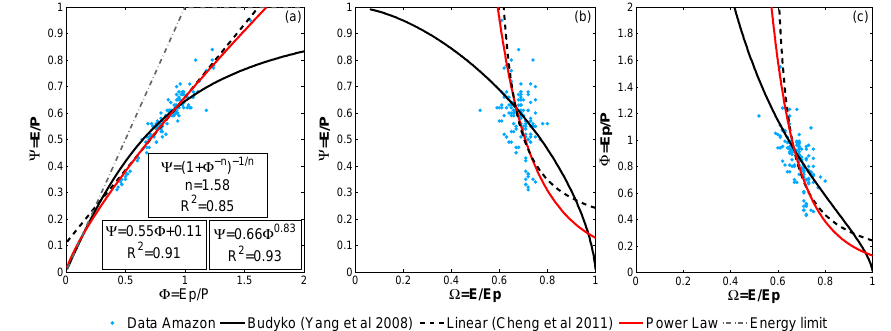
Figure 5. Bi-dimensional projections of the 3-D space for the 146 Amazon River